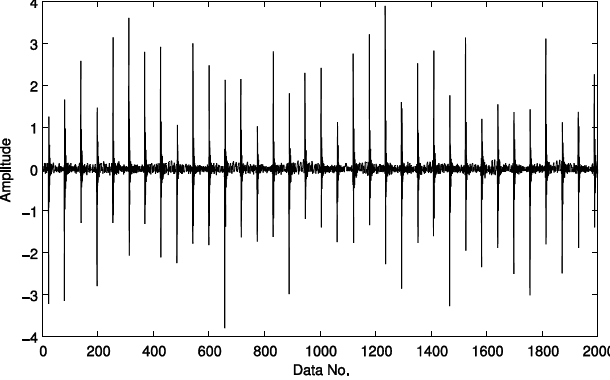
Figure 7. The vibration waveform of a bearing with an outer race